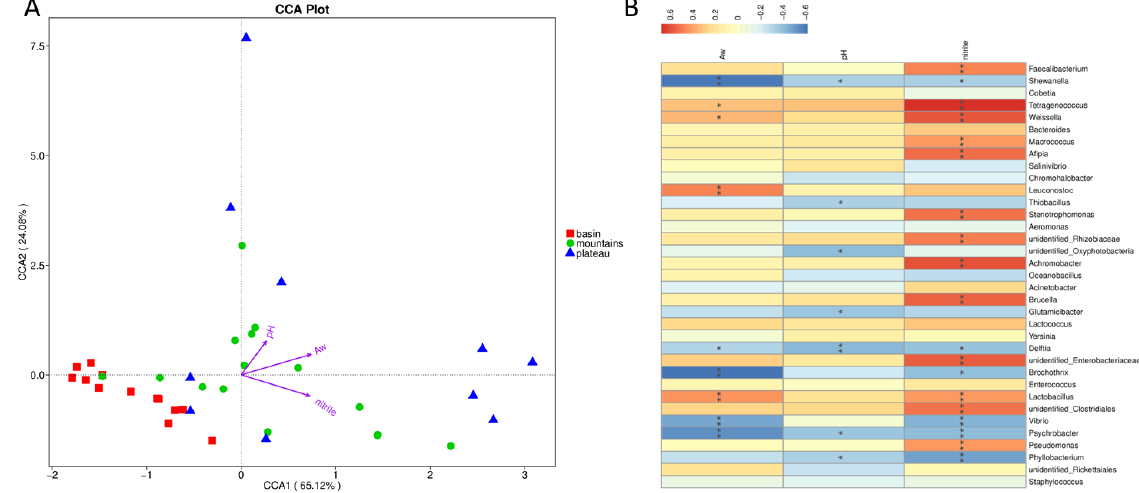
Figure 5. The parametric correspondence analysis ( A ) and Spearman analysis ( B ) of the top genera and environmental factors among the three regions.